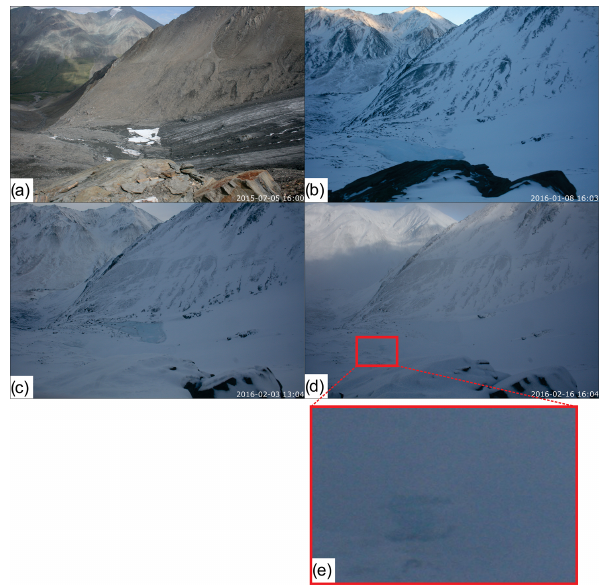
Figure 2. Glacier B tongue and hydrological activities visible in the TLC1 images. Panel (a) shows Glacier B’s tongue, proglacial field, proglacial icing, and the east side of the valley at the camera instal- lation. Panels (b) and (c) illustrate flooding events on the west (b) and the east (c) side of the proglacial field; panels (d) and (e) show flooding occurring on the bottom east side of the proglacial